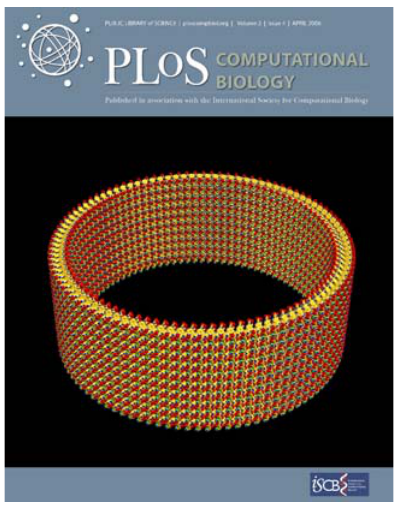
publish great work involving computational analyses on all biological scales. We want to make connections between researchers who are using conceptually related approaches to tackle diverse issues in